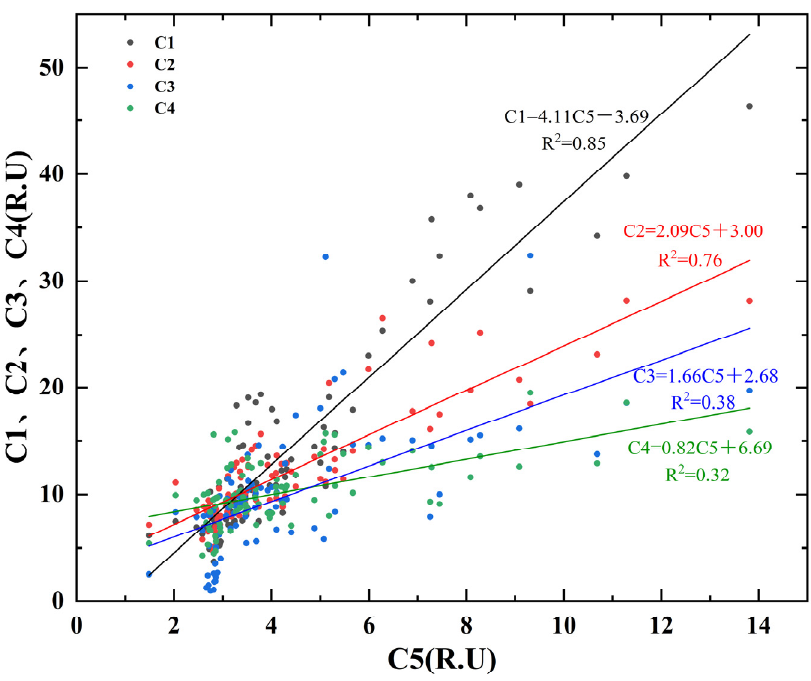
Figure 8. Relation of C5 to C1, C2, C3, and C4.